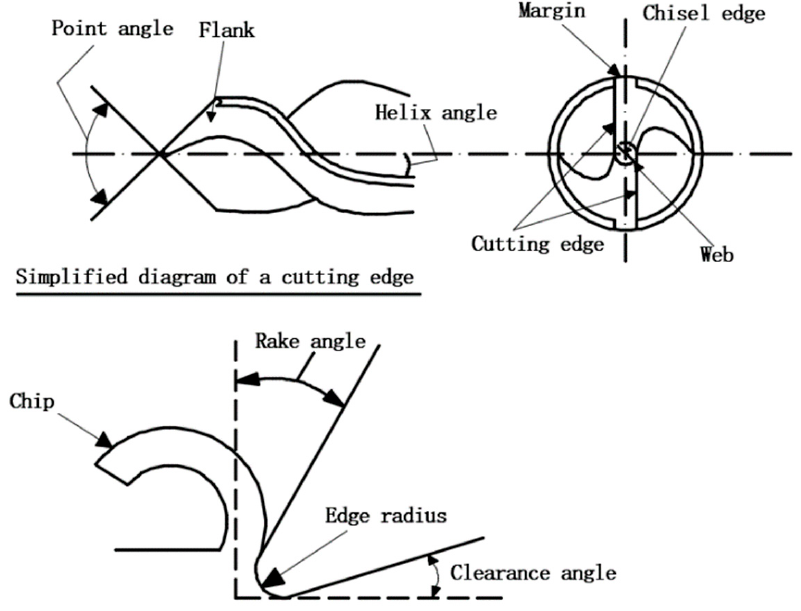
Figure 1. Simplified bit geometry.